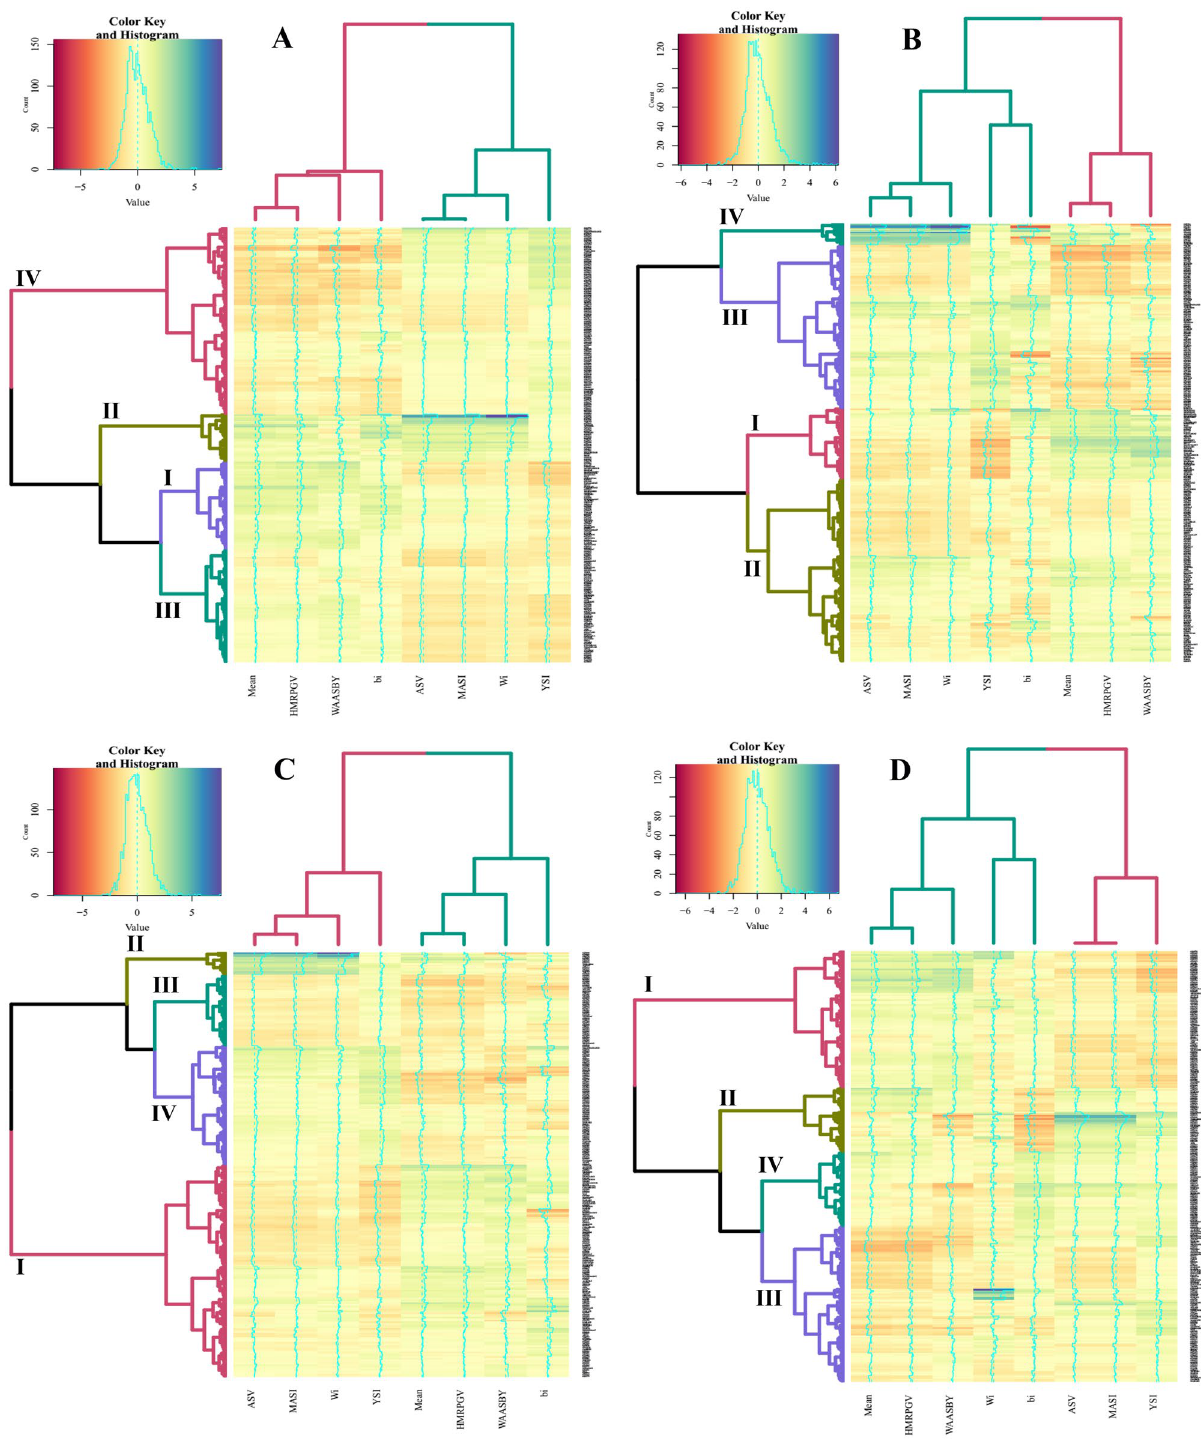
Figure 2. Heatmap based on stability indicators for grain yield ( A ), number of grains ( B ), spike weight ( C ), and plant height ( D ) in Iranian wheat landraces and cultivars. I: high mean and stable, II: high mean and unstable, III: low mean and stable and IV: low mean and unstable. Mean: average trait in all environments, ASV: AMMI stability value, b i : Finlay-Wilkinson regression, W i : Wricke’s ecovalance measures, MASI: Modified AMMI stability index, YSI: Yield stability index, HMRPGV: harmonic mean of the relative performance of the genetic values, WAASBY: weighted average of absolute scores from the singular value decomposition of the matrix of BLUP for the GEI effects generated by an LMM and response variable. The heatmaps were created using "gplots" package "heatmap.2" function in R 32